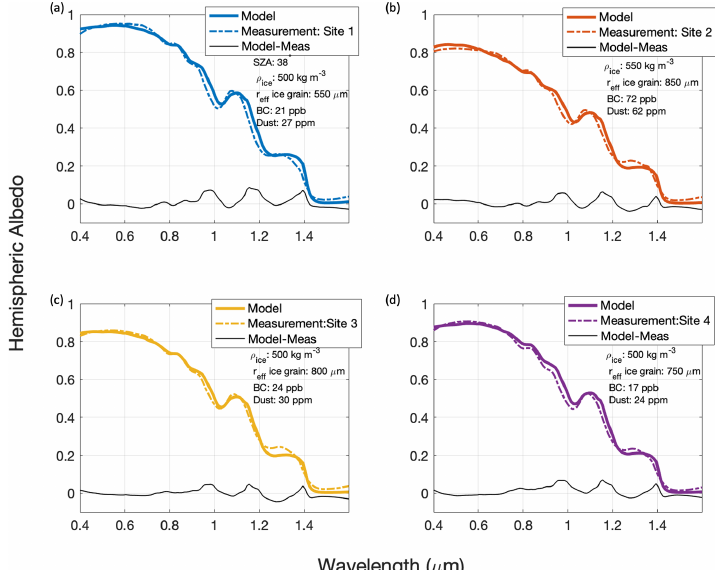
Figure 12. Spectral albedo measured by Kaspari et al. (2015) compared to SNICAR-ADv4 modeled spectral albedo. The model parameters for snow and ice properties are loosely based on qualitative descriptions, and the dust and black carbon concentrations are tightly constrained by quantitative measurements by Kaspari et al.